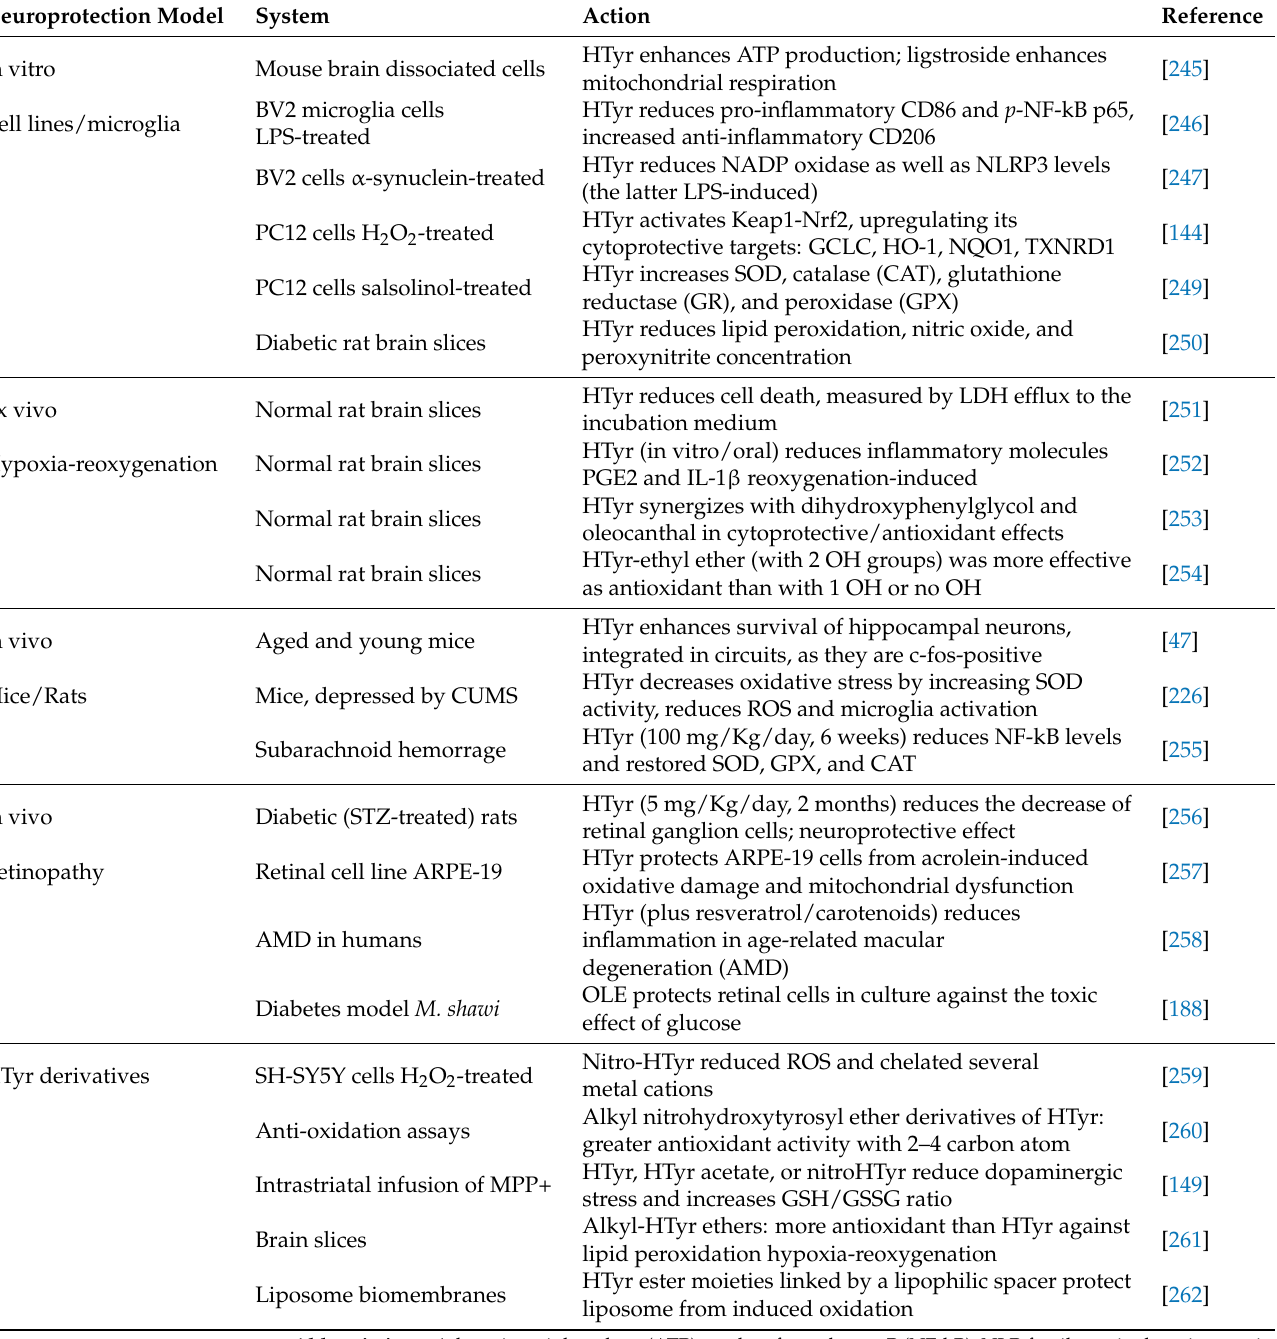
Table 3. Neuroprotective effects of